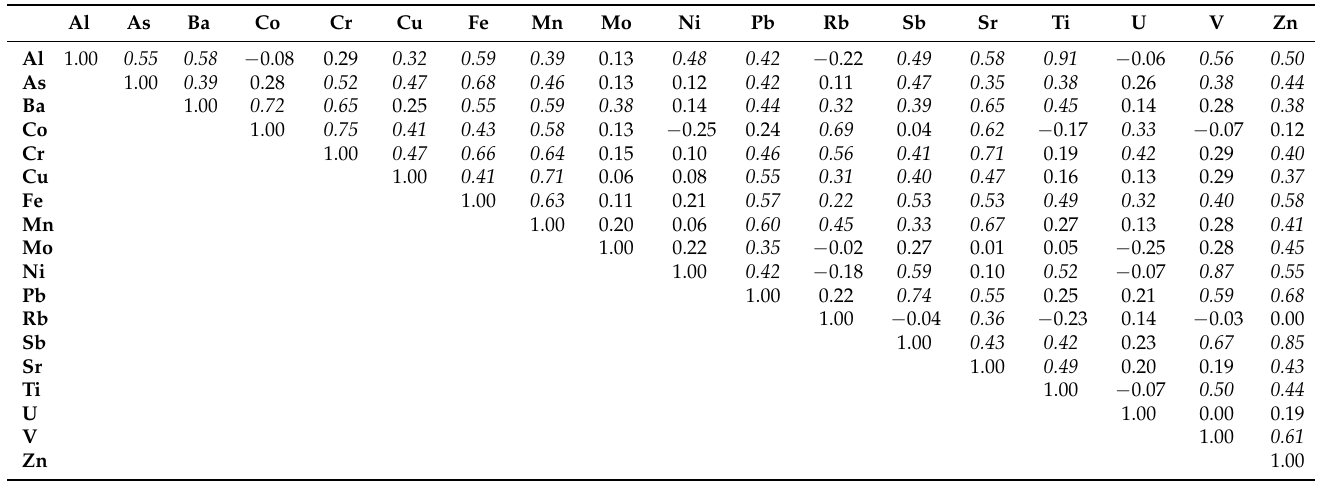
Table 2. Spearman correlation matrix of variables measured at the lichen samples from the Syracusan petrochemical complex. The significant cases are indicated in italics. Upper critical value: